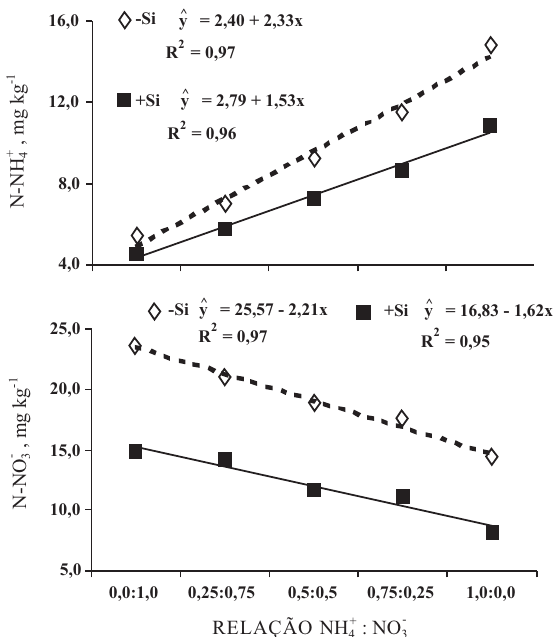
Figura 1. Teor de amônio N-NH 4+ e de nitrato [N-NO 3- ] no solo, em função de diferentes relações N-NH 4+ : N-NO 3- , na presença e ausência de silício no solo não-rizosférico do